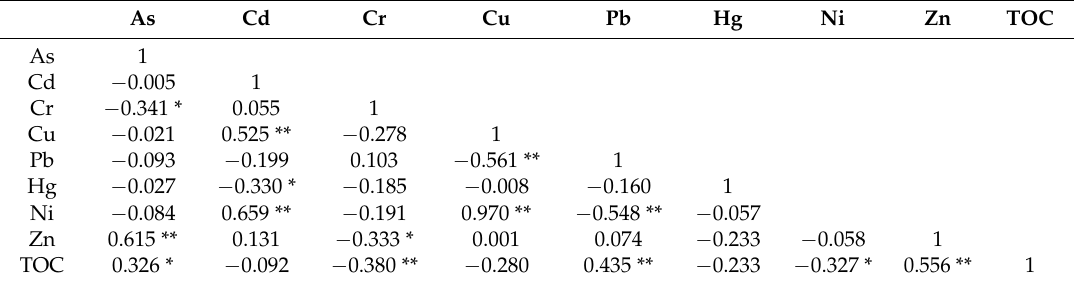
Table 4. Pearson square correlation of heavy metals in sediment samples.